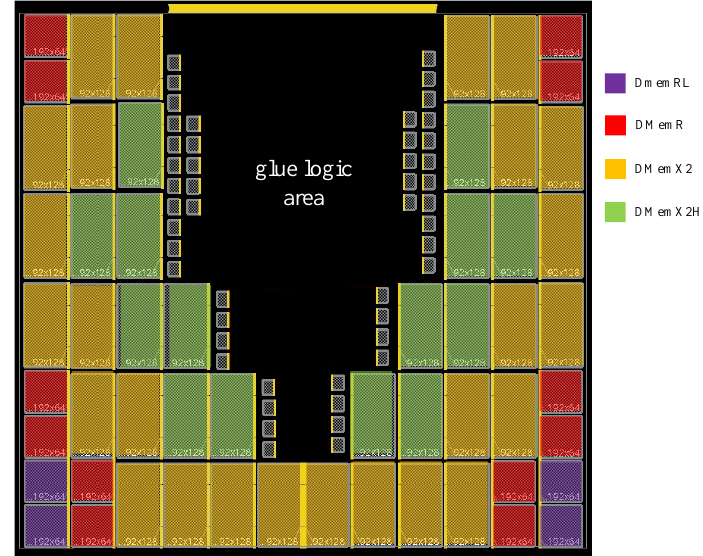
Figure 6. SRAM placement in co-operative methodology.